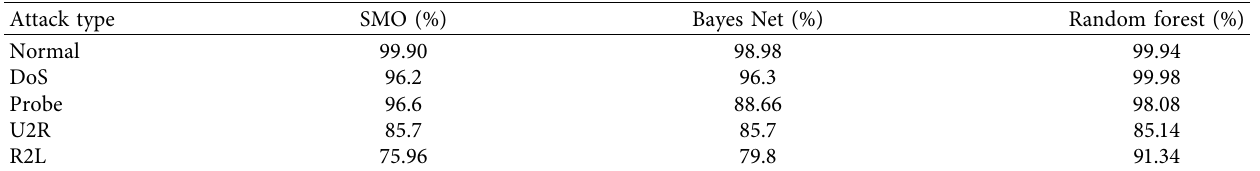
Table 3: Performance comparison of the three classifiers.